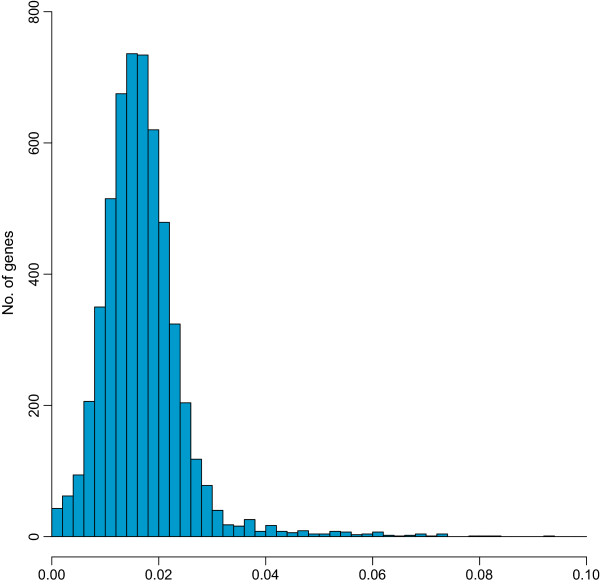
Allelic divergence observed in T. cruzi. Histogram of nucleotide diversity (π), showing the distribution of allelic variation in the analyzed data. Alignments (loci) meeting our criteria for good quality (see main text) and containing no more than 2 reference coding sequences from the CL-Brener genome, were used to calculate the nucleotide diversity values in the figure. The values of π were normalized over the effective length of the alignment (see Methods). For the histogram, the values were binned as shown in the x axis. Only values of π < 0.1, corresponding to 7,624 alignments (99.8%) were included in the graphic.